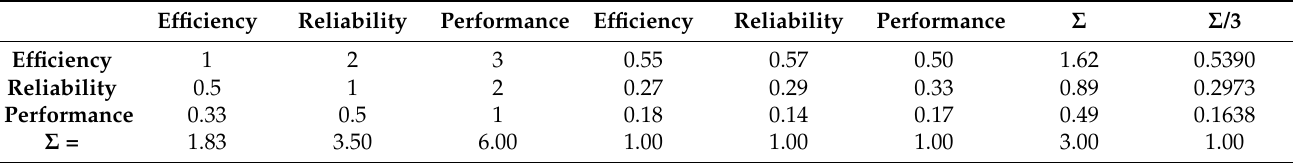
Table 2. AHP comparison matrix of the factors related to motors in electric vehicles.